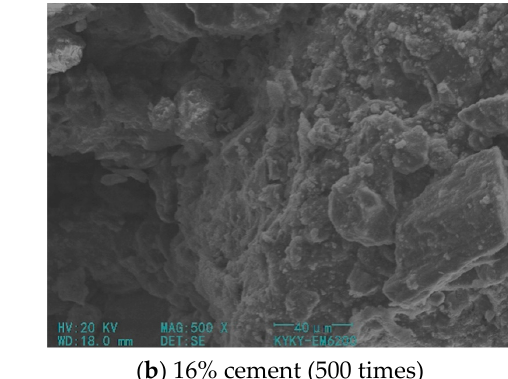
Figure 7. SEM picture of plain cement–soil.